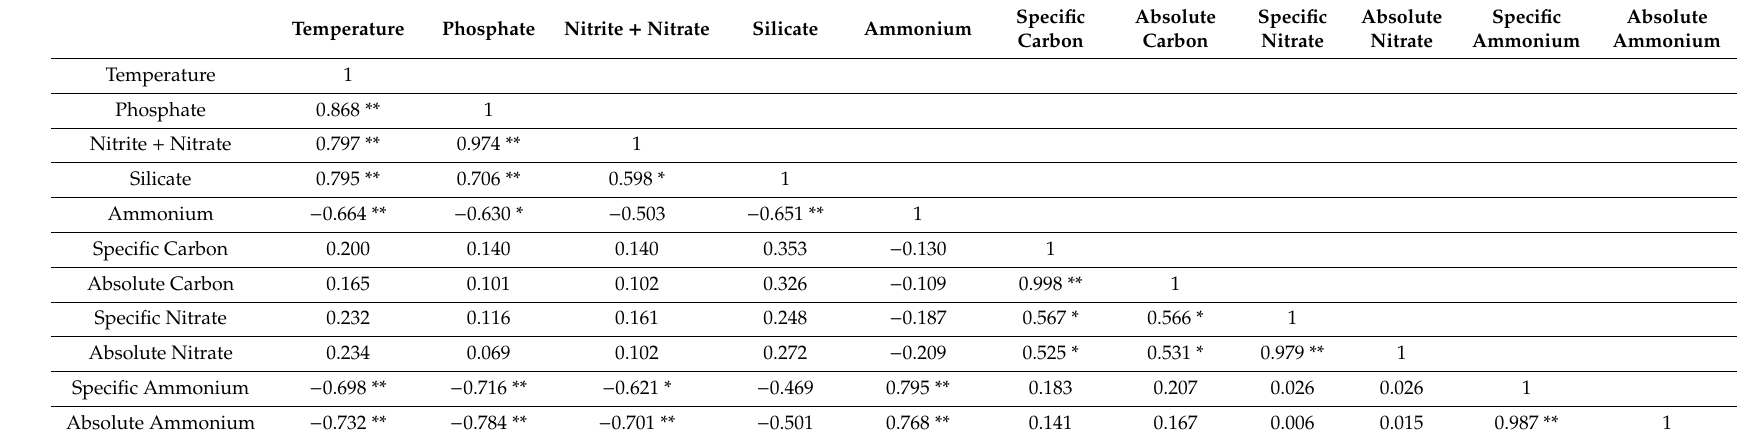
Table 3. Pearson’s correlation analysis of specific and absolute total carbon and nitrogen uptake rates ( n = 15). Significant correlations are indicated as follow: * p < 0.05, ** p <